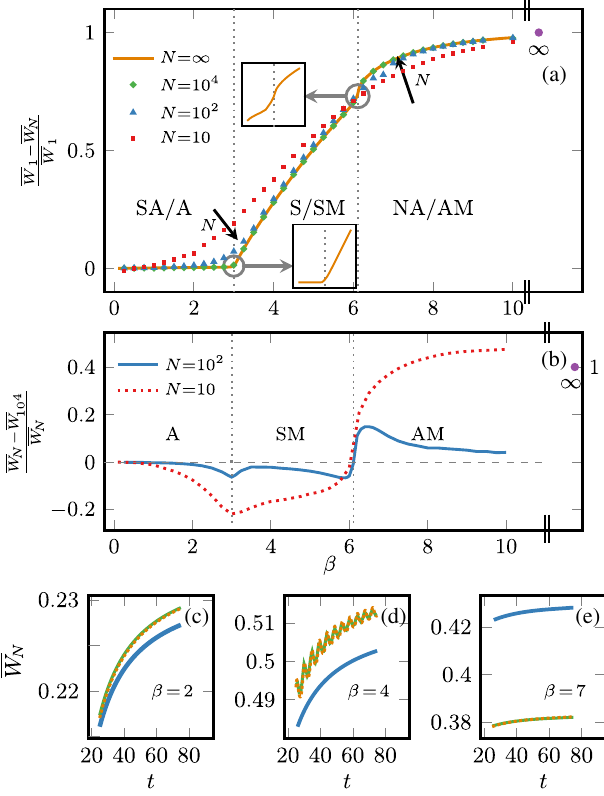
FIG. 10. (a) Difference of the dissipated work for a single unit, ¯ W ¯ W , for inverse 1 , and for a unit in a network of size N , N temperatures β ¼ 0 … 10 . The time t ¼ 500 is chosen to ensure ¯ W that has converged to its (metastable) asymptotic value. N (b) Difference of the dissipated work per unit for networks of different sizes with N < 10 4 , for β ranging from 0 to 10 and thus covering all three phases: SA, S, and NA in the MF and A, SM, and AM for finite metastable systems. As in (a), the time is t ¼ 500 . The purple closed circles in (a) and (b) represent the analytic expression given by Eqs. (51) and (52), respectively. ¯ W (c) – (e) Plot of for selected values at β ¼ 2 , 4, 7 and system N sizes N ¼ 10 2 (blue solid line) and N ¼ 10 4 (green solid line). These are the same data as those underlying the blue solid curve in (b), but, for better visualization, the time t is restricted from 20 to 80. For comparison, the MF limit (orange dashed lines) is overlaid in (c) – (e). In each plot, all finite systems are simulated sampling 10 6